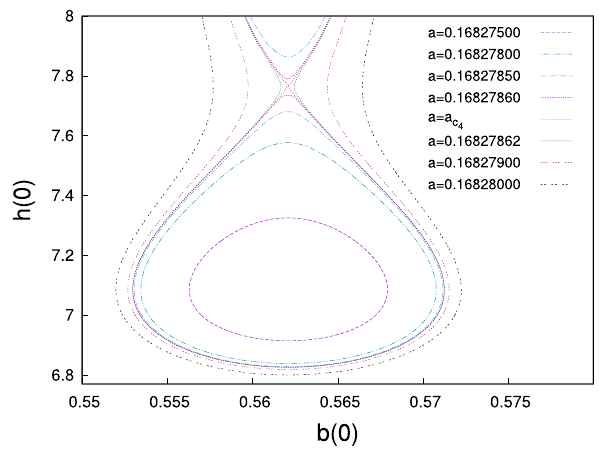
Fig. 2 Zoom and extenstion of the 2D phase diagram Fig. 1a, showing h ( 0 ) versus b ( 0 ) into the region of the 4th bifurcation point a c